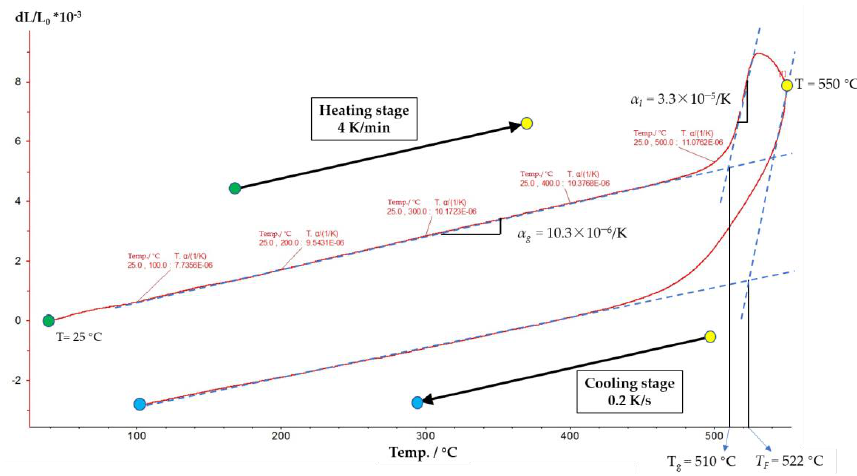
Figure 7. Thermal expansion curve measurement result.